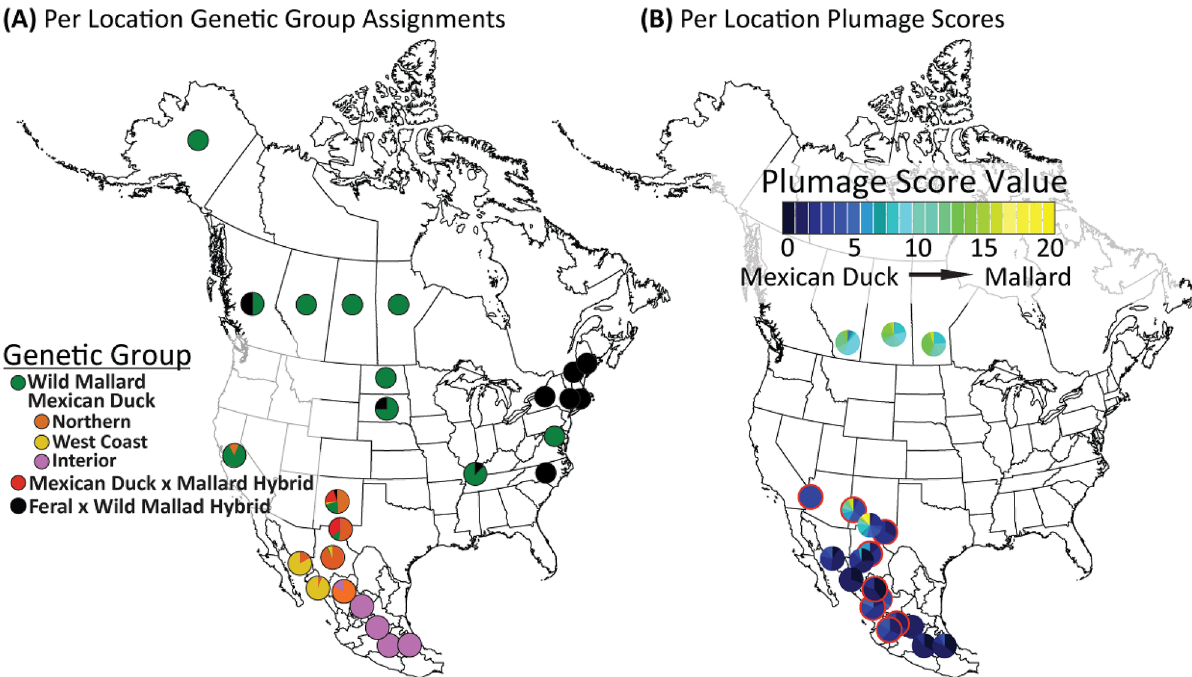
Figure 4. ( A ) Proportion of samples per geographical location with assignments to specific genetic groups as determined through population genetics analyses (Figs. 1 and 2; also see Supplementary Materials Figs. S2 & 3). ( B ) Plumage score proportions of samples per geographical location (Fig. 3; also see Supplementary Materials Fig.